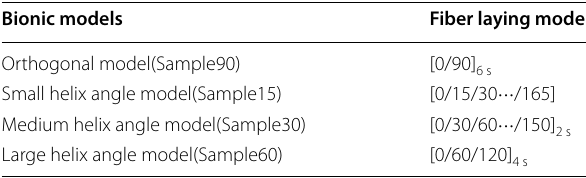
Table 1 Models of multilayer fiber bionic composites Bionic models